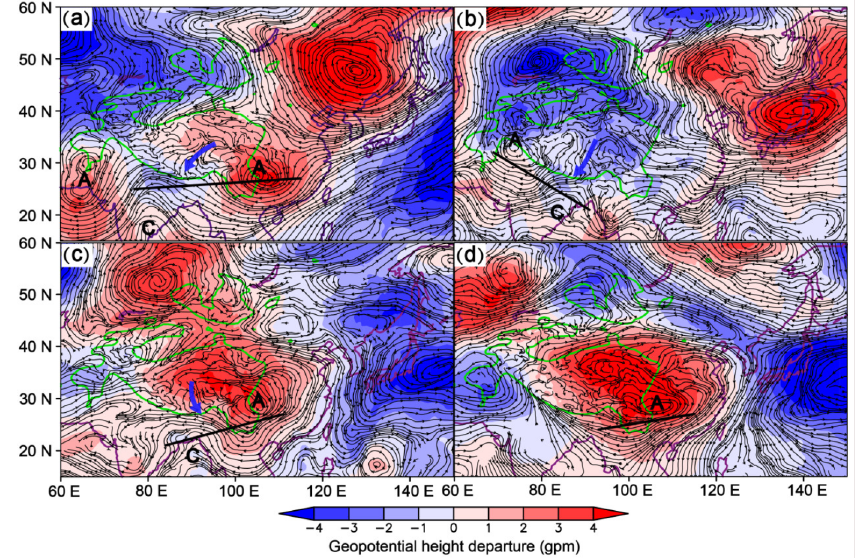
Figure 8. As in Figure 4, but for 500 hPa. The black lines in ( a – d ) are for the position along which the cross-section in Figure 9a–d is made. The blue arrows mark the northerly currents that affect the southeastern part of the Qinghai-Tibet Plateau. C and A stand, respectively, for the centers of the cyclonic and anticyclonic systems. The areas bounded by green lines are for the Qinghai-Tibet Plateau and the Mongolian